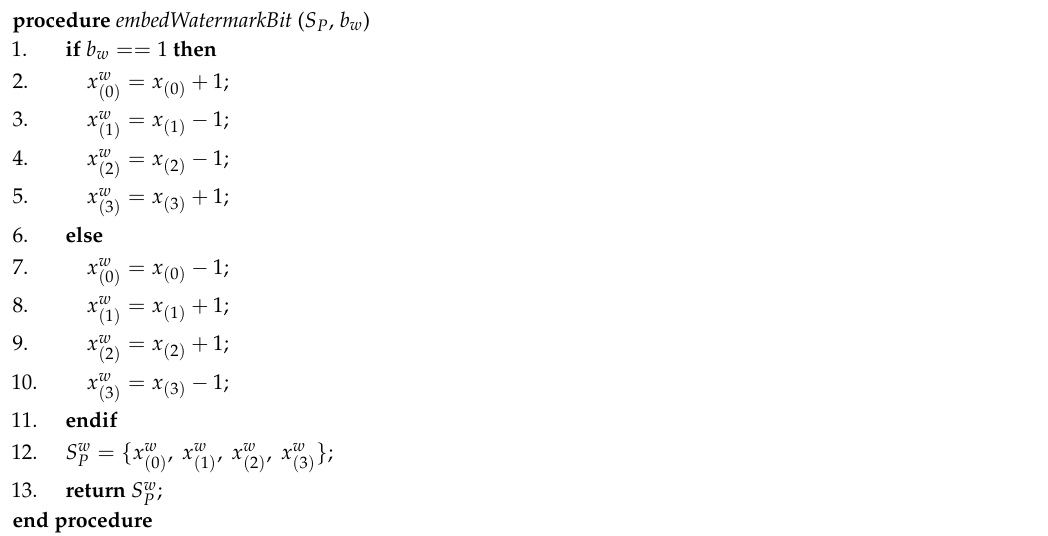
Algorithm 1 The “embedWatermarkBit” procedure (pseudo-code from [13]) procedure embedWatermarkBit ( S P , b w